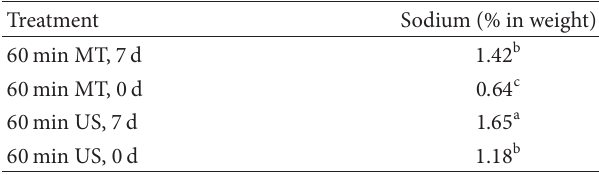
Table 2: Content of sodium in beef samples (longissimus dorsi) marinated with/without ultrasound and with/without